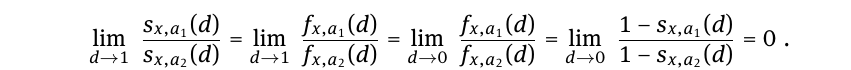
Differentiating 1− s x , a ( d ) we get the probability density function of the large portfolio default rate,